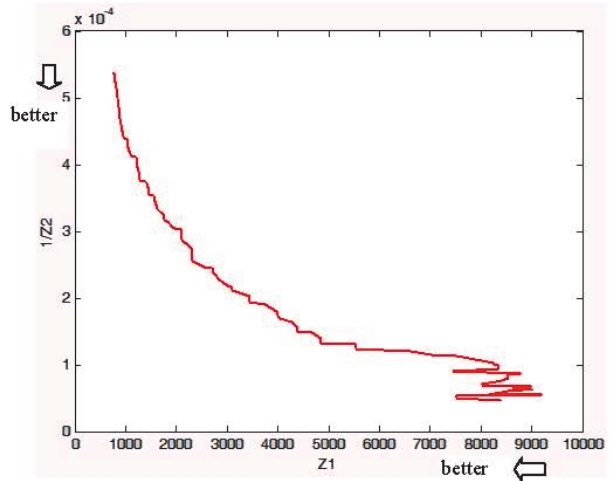
Fig. 12. Set of Pareto optimal solutions (x-axis Z1: solutions of the first objective function; y-axis 1/Z2: inverse of the solutions of the second objective